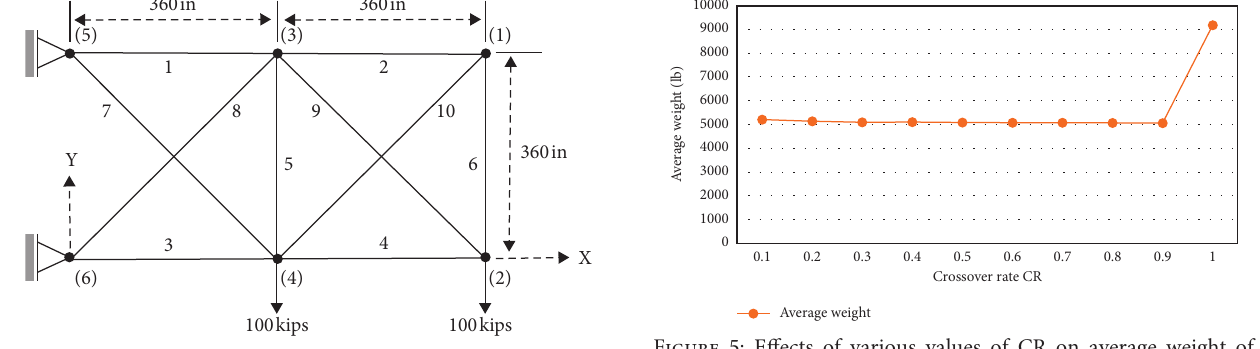
Figure 3: Configuration of the 10-bar truss (reproduced from Lu et al. [29], under the Creative Commons Attribution License/public domain).